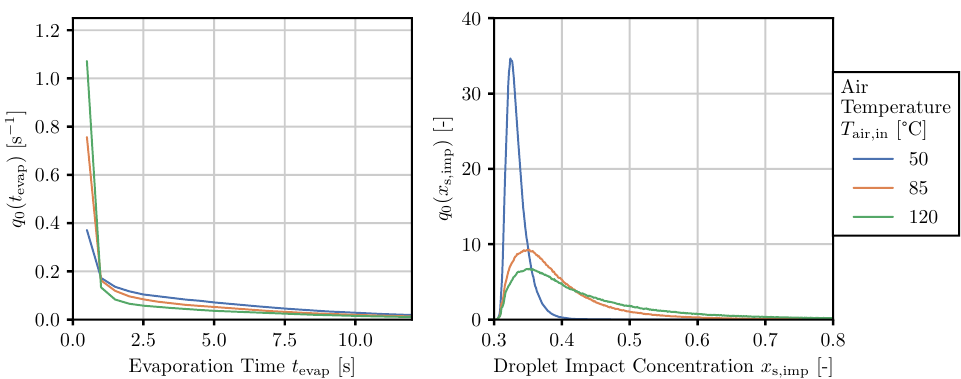
Figure 17. Influence of air temperature T air,in on the tracked quantity distributions for the laboratory- scale case at ˙ V air = 105m 3 h − 1 , p spray = 1.8bar, ˙ M spray = 15g min − 1 , T spray = 70°C unless other- wise